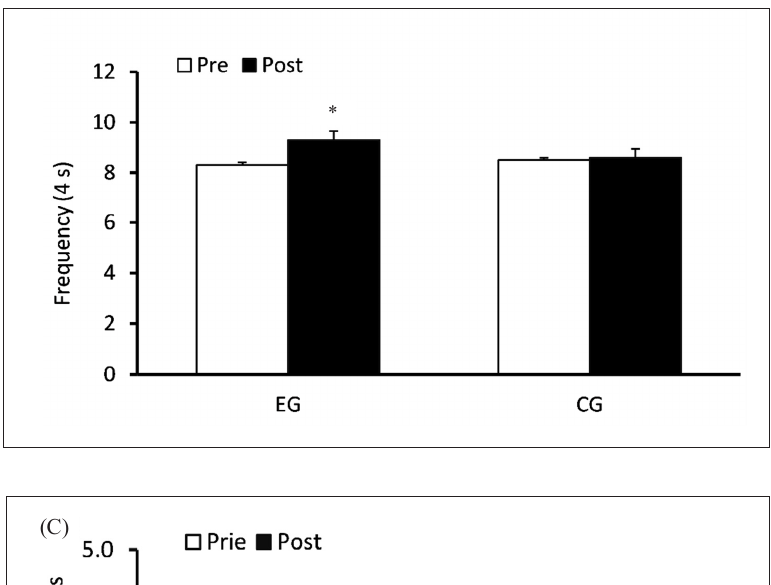
Figure 1. Knee flexion-extension frequency during 4 s period in low load high velocity elastic band (EG) and control group (CG) before and after training (mean ± SD )